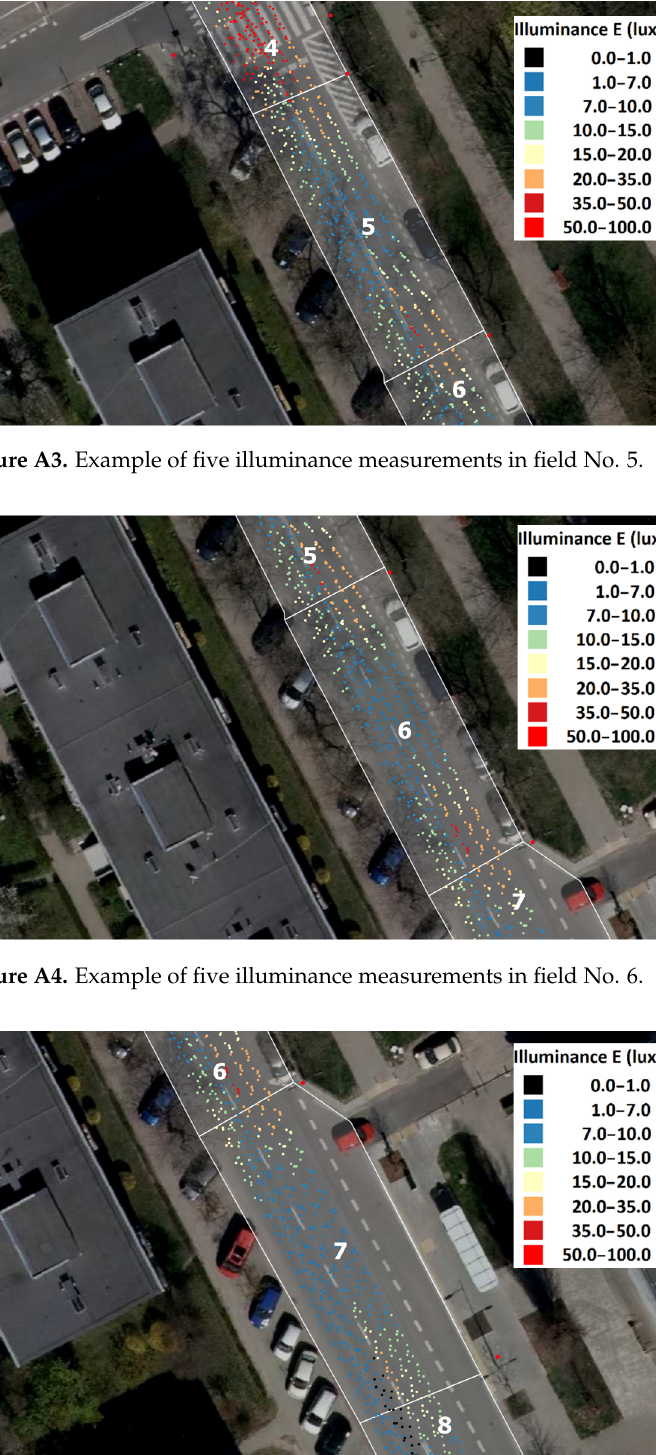
Figure A2. Example of five illuminance measurements in field No. 3.